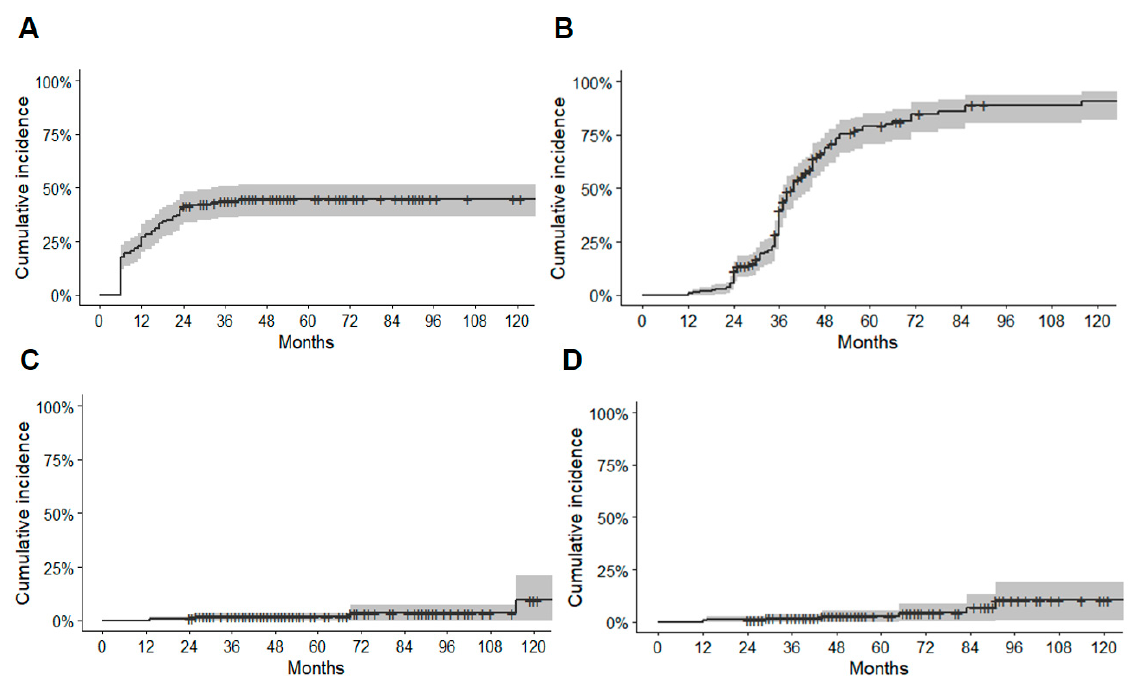
Figure 2. Kaplan–Meier curves. ( A ) Kaplan–Meier curve for radiation-induced changes (RICs). ( B ) Kaplan–Meier curve for obliteration. ( C ) Kaplan–Meier curve for latent period hemorrhage. ( D ) Kaplan–Meier curve for delayed cyst for- mation.